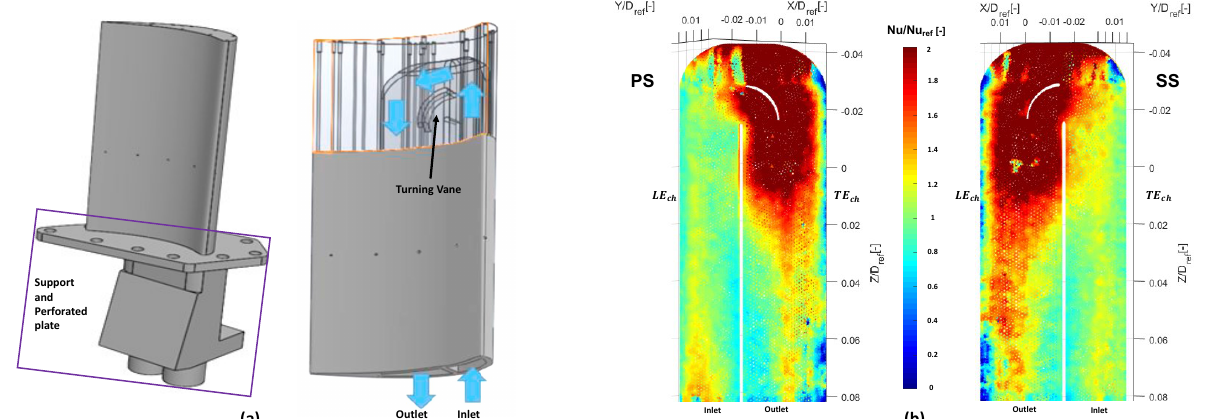
Figure 5. Blade with U-bend internal cooling channel, ( a ) Heat transfer distribution of internal cooling channel for pressure side (PS) and suction side (SS) for Re = 36,870 ( b